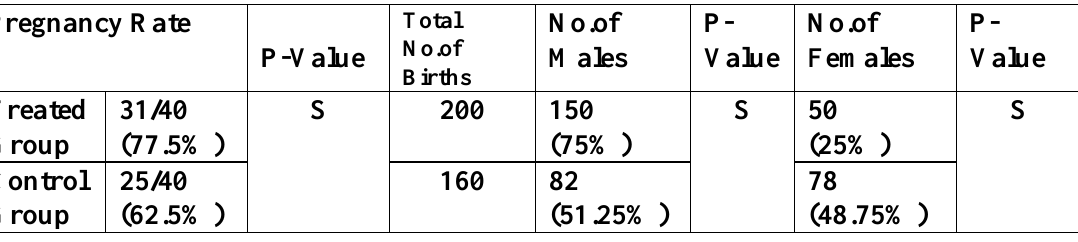
Table 1: Effect of Ericsson Albumin Method on Pregnancy Rate and Sex Selection in